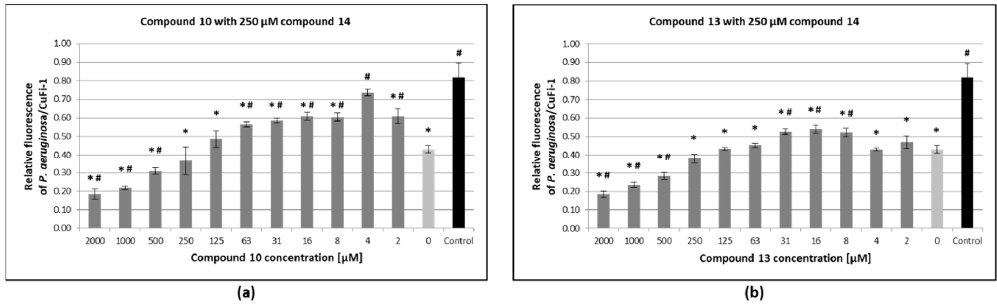
Figure 7. Adherence of P. aeruginosa on CuFi-1cells in the presence of compounds combination. Monolayers of PKH67-labeled CuFi-1 cells were incubated for 2 h with suspensions containing PKH26-labeled P. aeruginosa and 250 µM compound 14 combined with compound 10 or 13 (dark grey bars) or only 250 µM compound 14 (light grey bar). Suspension with PKH26-labeled P. aeruginosa in PBS was used as an untreated control (black bar). After discarding non-adhered bacteria, the relative fluorescence of adhered P. aeruginosa and CuFi-1 was quantified using Tecan Infinite M200 Pro. Results are expressed as a relative fluorescence ratio of P. aeruginosa /CuFi-1 plotted as a function of anti-PA-IL compounds concentration. Plotted data are means ± SD of three independent incubations. * indicates significant difference from untreated control ( p < 0.05; Dunnett test). # indicates significant difference from experiment using only 250 µM compound 14 ( p < 0.05; Dunnett test). ( a ) Results for